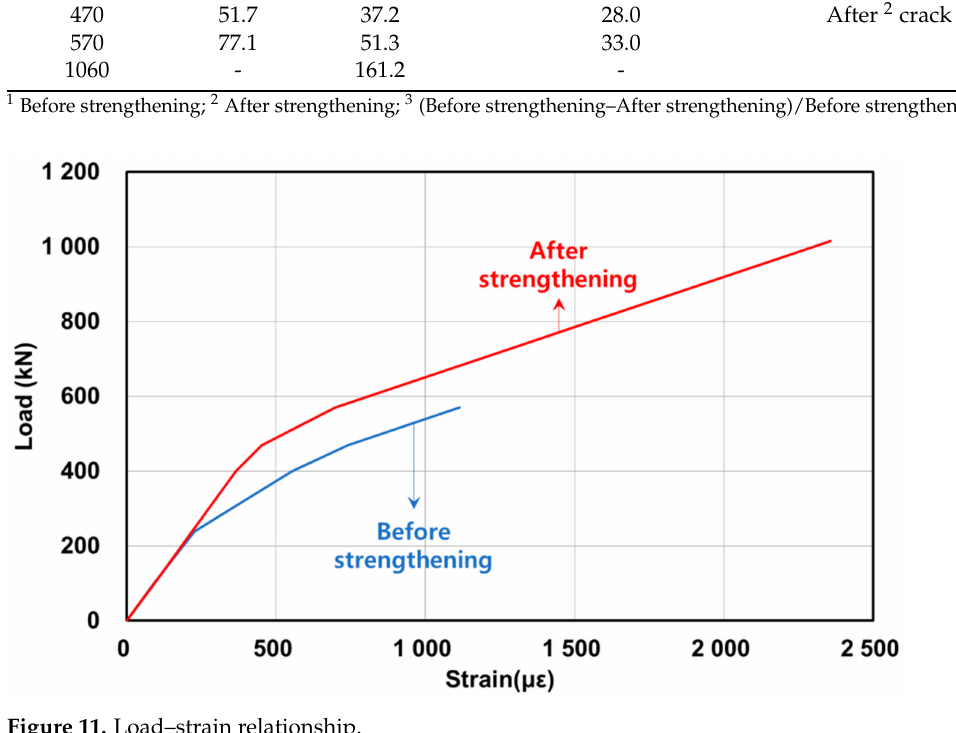
Figure 11. Load–strain relationship. Table 5. Comparison of internal tendon strain before and after